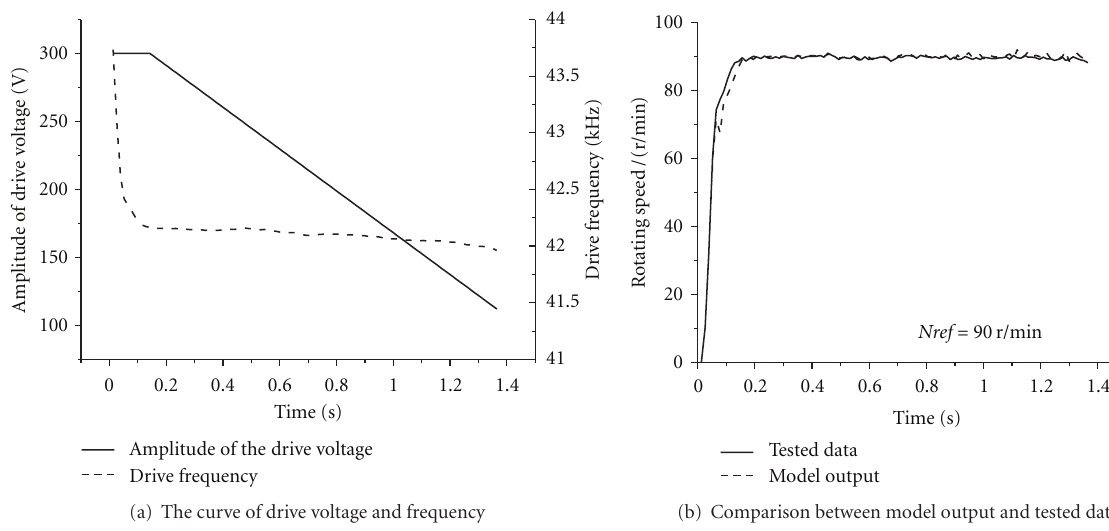
Figure 12: Step response comparison between model output and tested data ( Nre f = 90r/min, load torque = 0.2Nm).